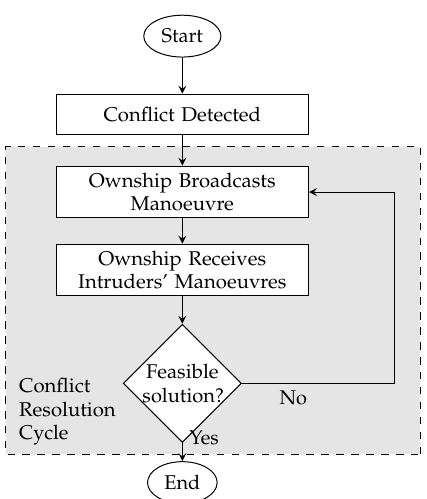
Figure 10. Iterations of an explicitly negotiated solution. Adapted from Yang [33]. Table 8. Properties of the CR methods used in